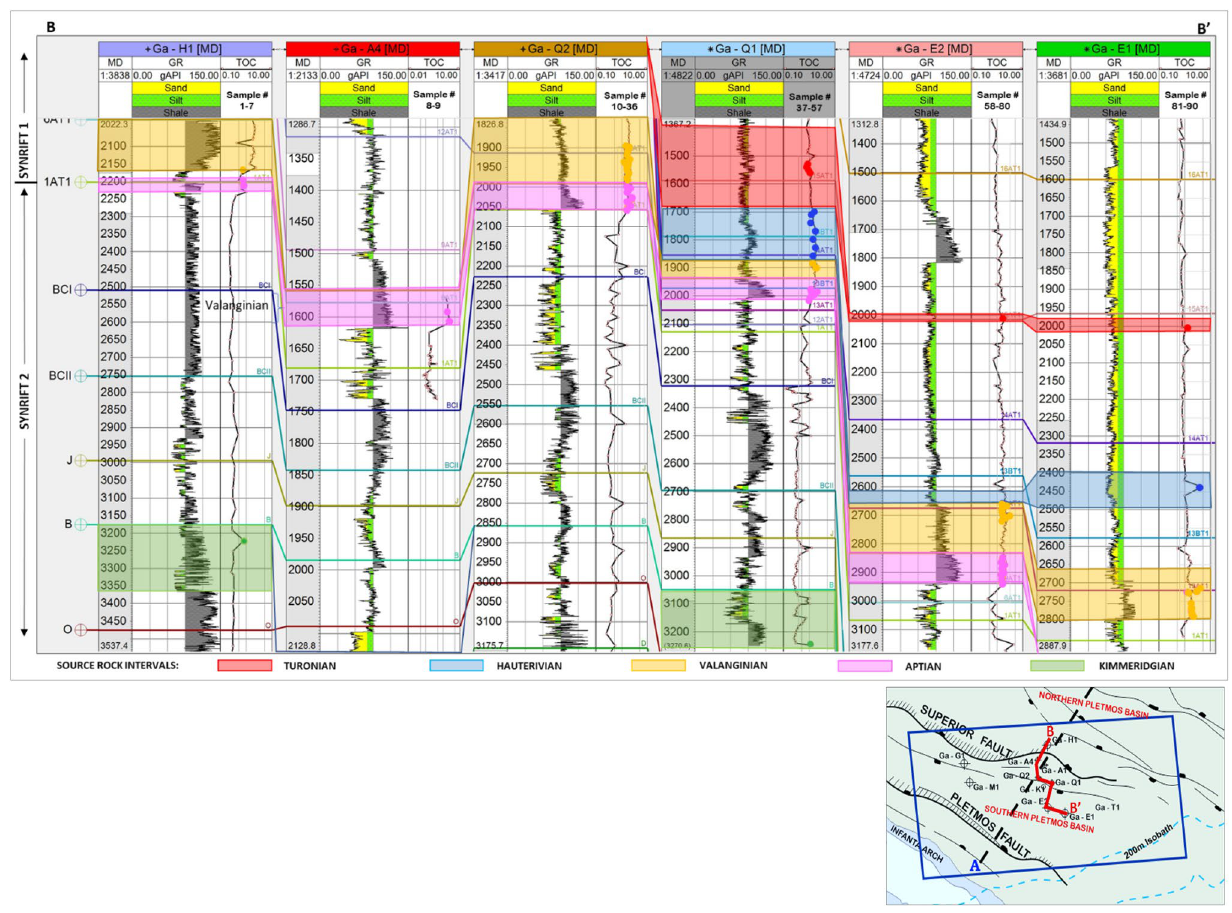
Fig. 5 NW–SE well correlation panel displaying the possible source rock intervals for selected wells within the study area. A reference is shown on the left Table 3 Organic matter quality and nature of expelled product at peak for the different source rock intervals adapted from Agbor (2017) Source